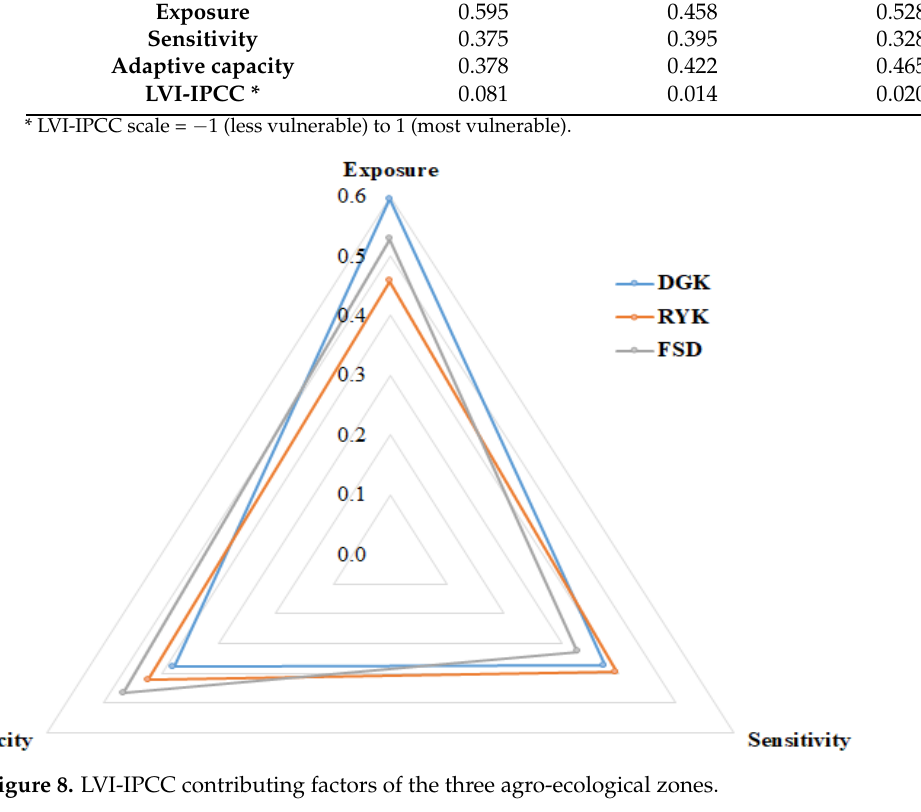
Figure 8. LVI-IPCC contributing factors of the three agro-ecological